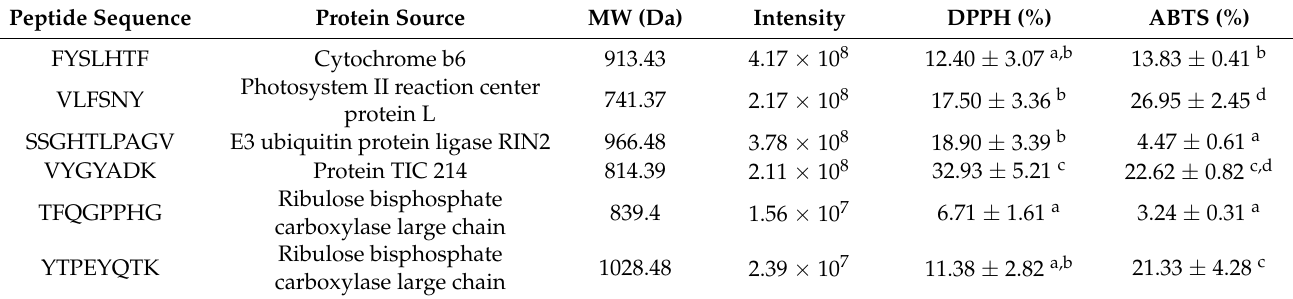
Table 1. Sequence and bioactivity of the selected antioxidant peptides.